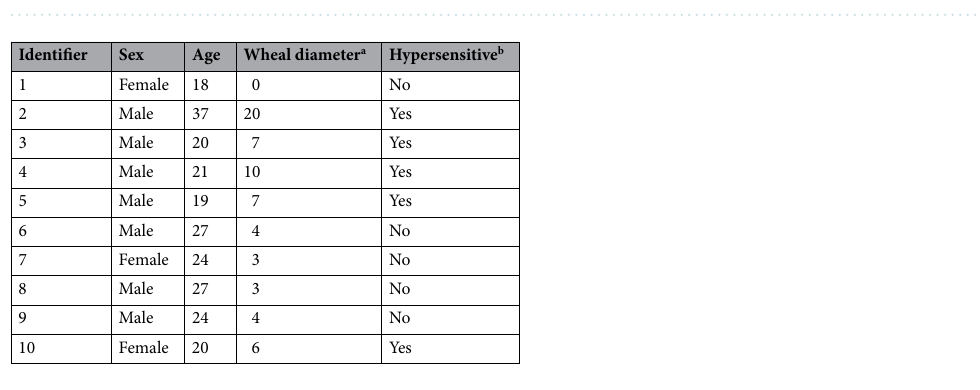
Table 2. Subject characteristics from antihistamine study. a Largest wheal diameter per subject in mm. b Hypersensitive was defined as any subject with a wheal > 5 mm in